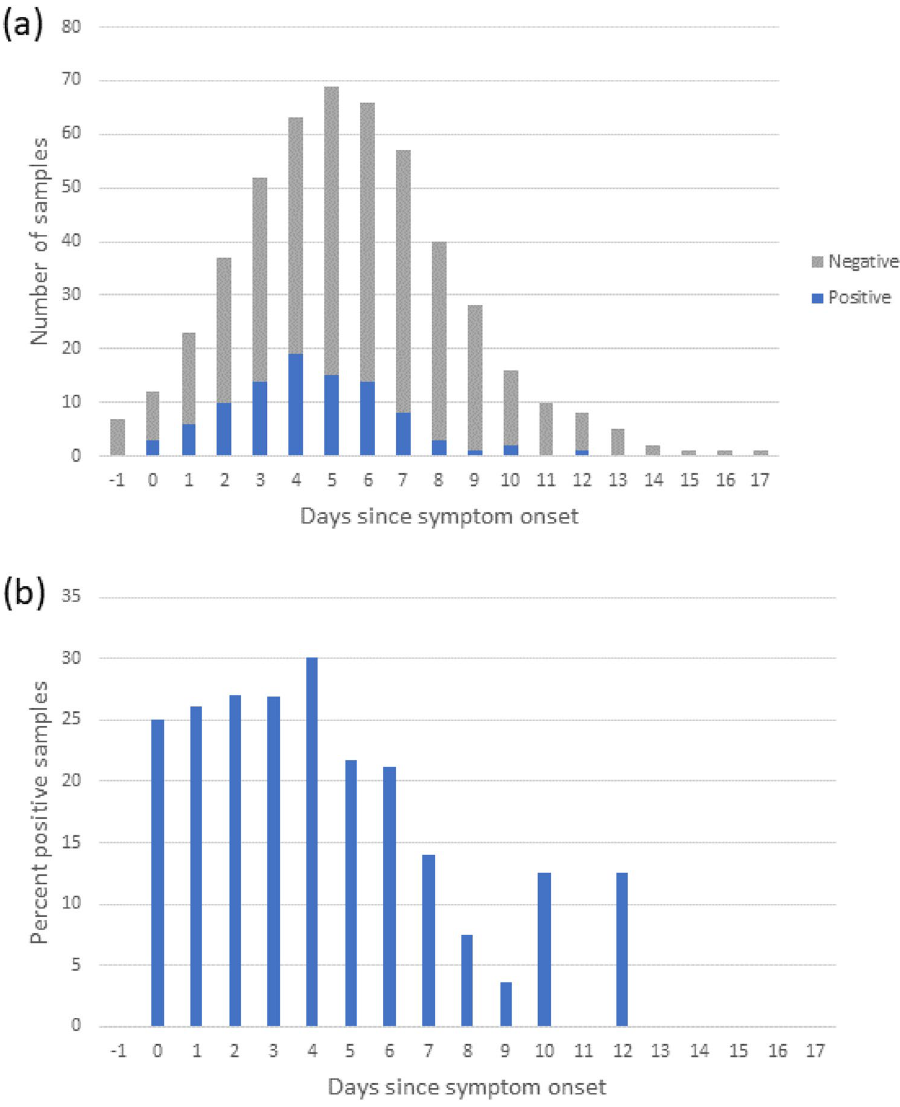
Figure 2. ( a ) Total number and number of positive air samples per day from symptom onset, and ( b ) percent positive air samples per day from symptom onset obtained through singing/loud talking from confirmed COVID-19